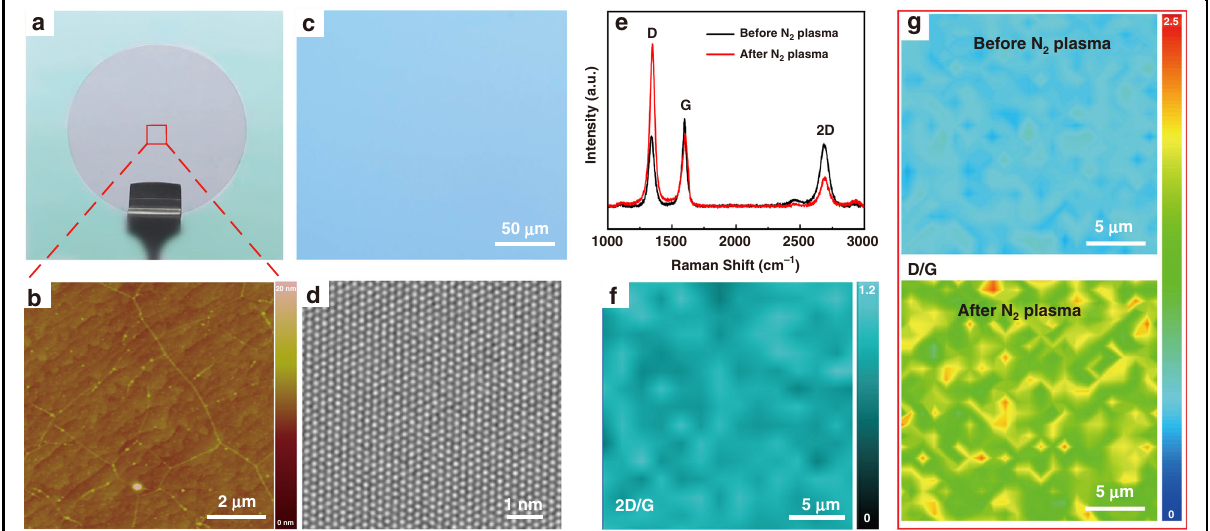
Fig. 1 AFM and Raman analyses of Gr-covered sapphire substrate. a Photograph of an as-grown 2-inch Gr/sapphire wafer. b AFM image of the as-grown Gr on sapphire. c OM image of the as-grown Gr fi lms after transferred onto SiO 2 /Si substrate. d Representative atomically resolved image of Gr. e Raman spectra of Gr on sapphire before (black) and after (red) N 2 plasma. f I 2D / I G ratio for the Gr fi lm in a 20 × 20 μ m 2 region. g Raman mapping of I D / I G obtained from Gr fi lm before (upper) and after (lower) N 2 plasma